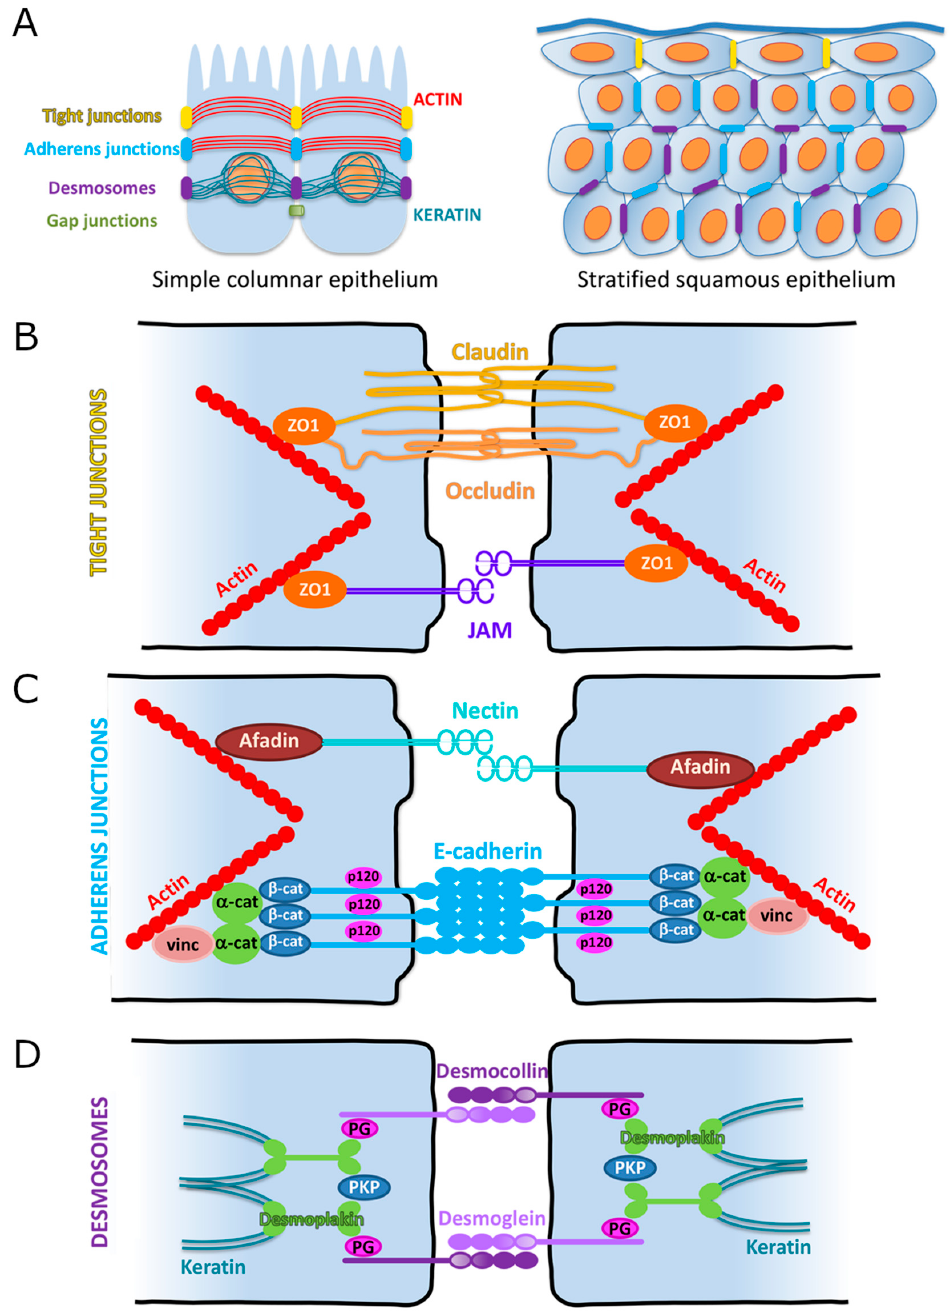
Figure 5. Schematic representation of cell–cell adhesion junctions in simple columnar and strat- ified epithelia . ( A ) Classic organization of cell–cell adhesions between two epithelial cells of a simple columnar epithelium ( left ). Note the apical localization of the tight junctions, superficial to the adherens junctions. Both of these junctions connect to the actin cytoskeleton. Desmosomes are more baso-lateral and connect to the keratin intermediate filaments. This organization is pre- served in a stratified epithelium ( right ), with desmosomes and adherens junctions mainly in the basal and suprabasal layers, while the tight junctions are exclusively found in the uppermost lay- ers. ( B ) Schematic of tight junctions. ( C ) Schematic of adherens junctions. α -cat = alpha-catenin; β -cat = beta-catenin; p-120 = p120-catenin; and vinc = vinculin. ( D ) Schematic of desmosomes. PG = plakoglobin; PKP =